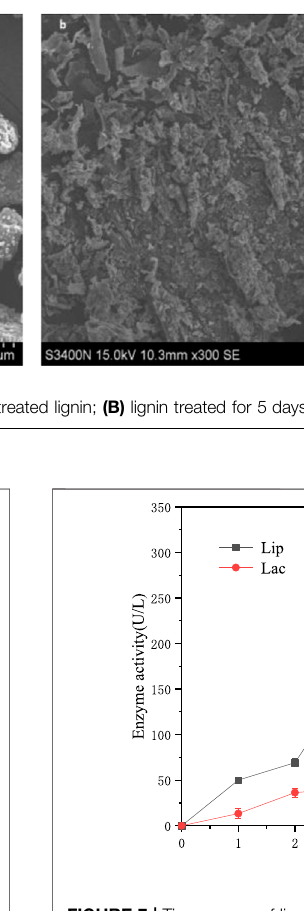
FIGURE 7 | Time course of lignin-degrading enzymes in the culture of strain TR-03. Initial concentration of alkali lignin was 2